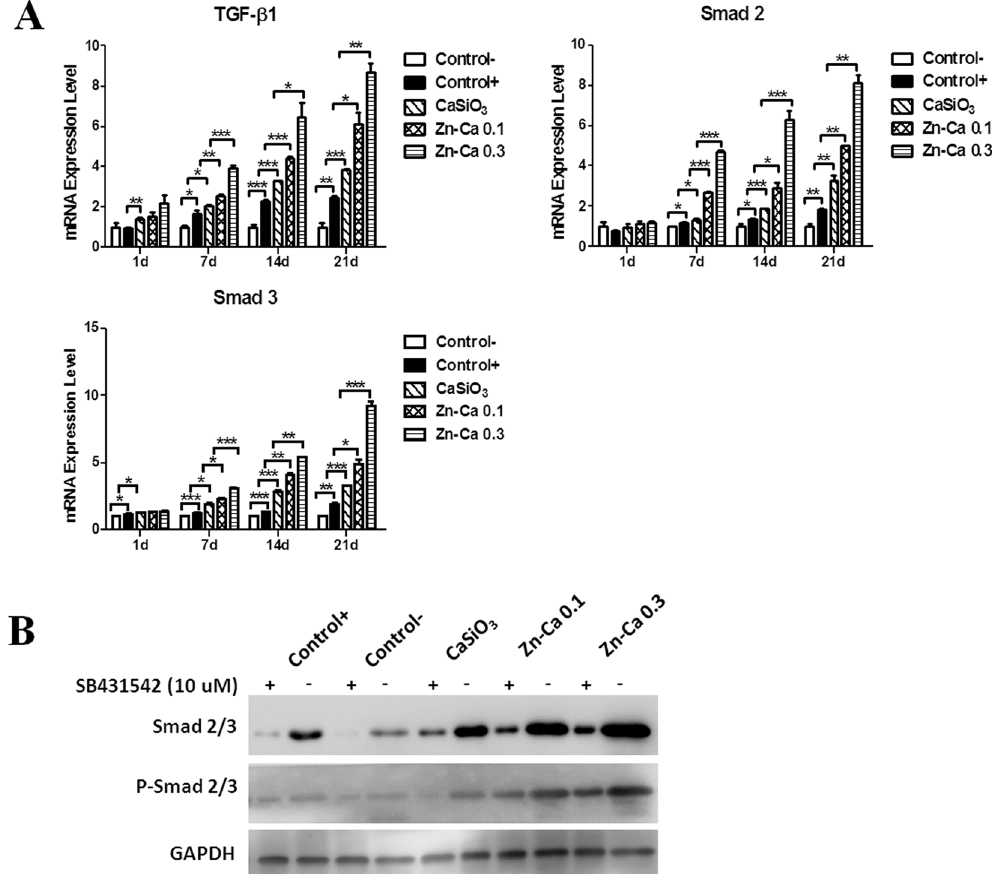
Figure 4. Detection of genes and proteins involved in the TGF- β /Smad signaling pathway. ( A ) Q-PCR quantification of genes involved in the TGF- β /Smad signaling pathway in BM-PCs cultured on Ti-6Al-4V (control) and on the CaSiO 3 , Zn-Ca 0.1 and Zn-Ca 0.3 coating surfaces at 1, 7, 14 and 21 days. The results were determined by the comparative CT method (2 − ΔΔ CT ). The bars represent the mean ± SD (n = 3). * p < 0.05, ** p < 0.01, *** p < 0.001. ( B ) Western blot analysis of the expression of Smad2/3 and phosphorylated